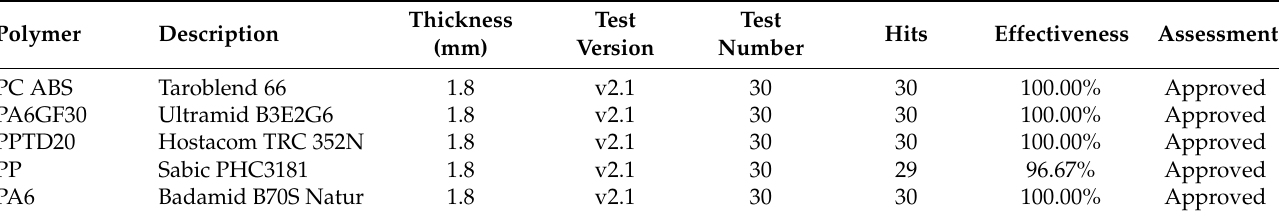
Table 6. Effectiveness tests for sensor 4.